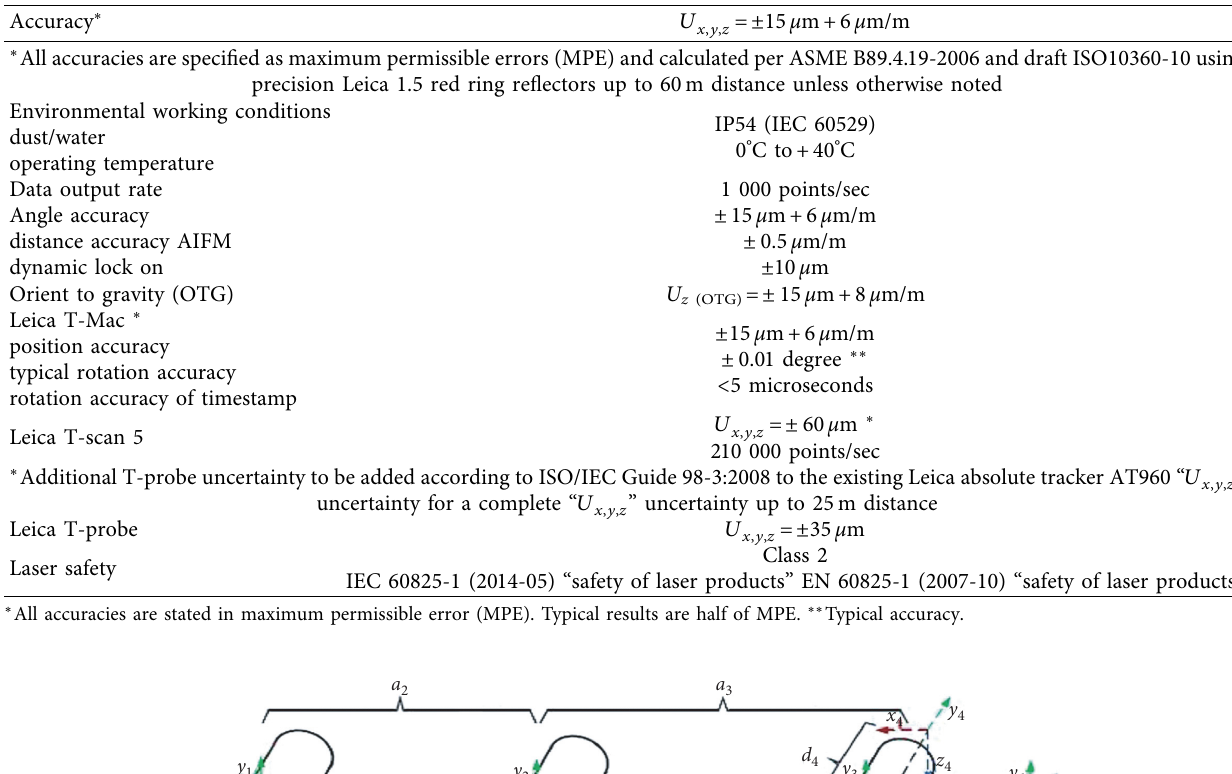
Figure 3: Experimental layout and front view of Leica measuring equipment. Table 1: Description of measuring equipment characteristics used in the experiment.